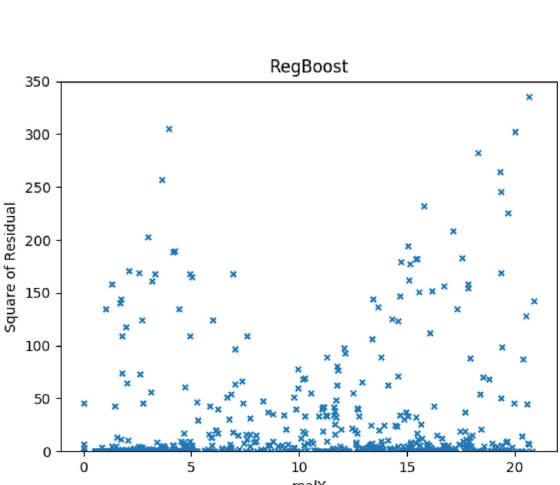
Figure 6. Square of residual